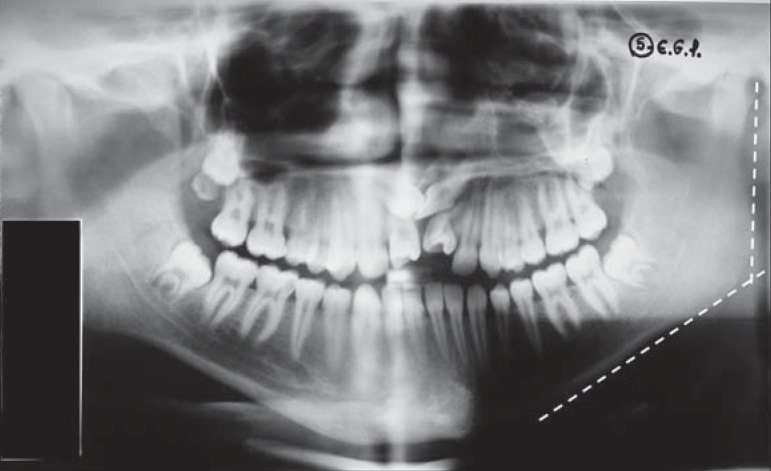
Panoramic radiography with the mandibular angle lines